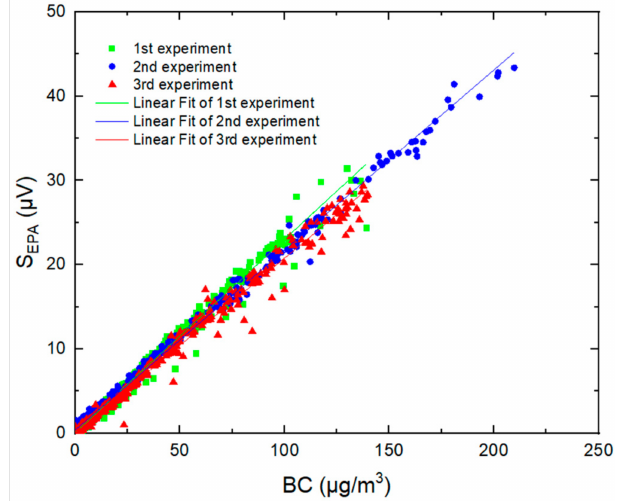
Figure 8. PA signals from the PASS versus BC mass concentrations measured by the AE51 during three